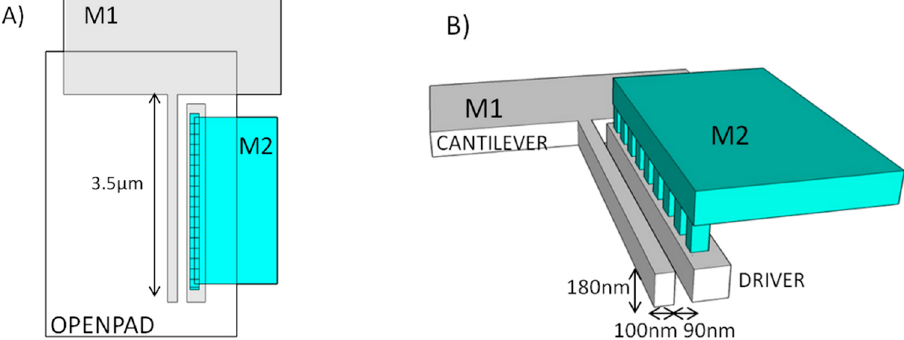
Figure 2. Schematic view of M1 configuration in order to get a 90 nm gap. ( A ) Top view schematic, showing M1 and M2 layers and open pad for releasing. ( B ) Three dimensional schematic showing M2 layer and M2-M1 vias to anchore the M1 driver and keep a reduced 90 nm gap between cantilever and driver.